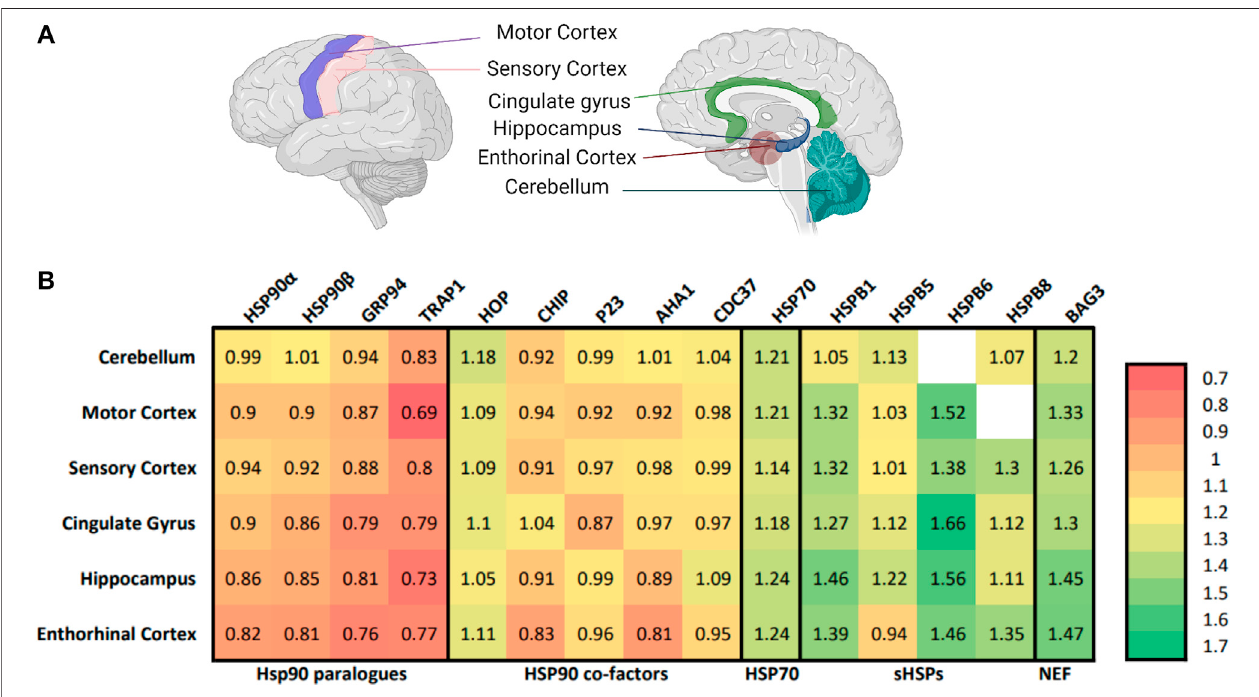
FIGURE 1 | TRAP1 is down-regulated in different areas of the AD-brain. (A) The selected brain regions for proteomic analysis comparing patients with AD to non- AD counterparts (Xu et al., 2019).On the left, the lateral view oftheleft side ofthe brain, which containsthe motor cortex and the sensorycortex.Onthe right the sagittal cut, revealing the cingulate gyrus, hippocampus, enthorinal cortex and cerebellum. The cingulate gyrus, hippocampus and enthorinal cortex are selected to represent heavily affected areas of the brain, the motor cortex and sensory cortex are less affected, while the cerebellum seems to be spared. Figure made with BioRender. (B) Heat map with the relative expression of elements of the protein quality control in the AD-brain compared to non-AD counterparts in different areas of the brain. Numbers represent the relative expression of that protein in an AD-patient compared to a non-AD counterpart (Koopman and Rüdiger, 2020). Included are the Hsp90 family, co-chaperones of HSP90, small heat shock proteins and nucleotide exchange factors. Notable is that the whole HSP90 family is affected in AD, with TRAP1 showing the largest decline in all areas of the